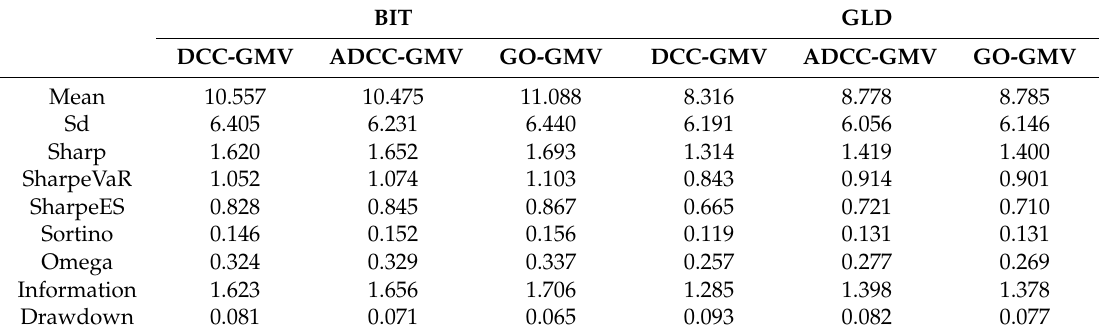
Table 8. Portfolio comparisons: Long only.